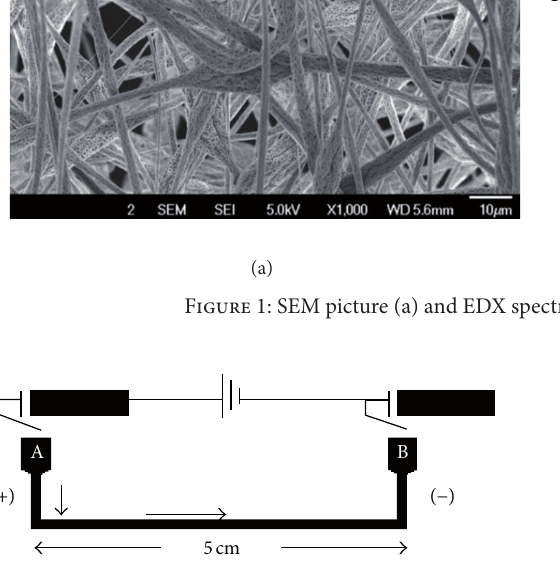
F 2: Schematic diagram of capillary-microreactor. A and B are reservoirs (disposable pipette